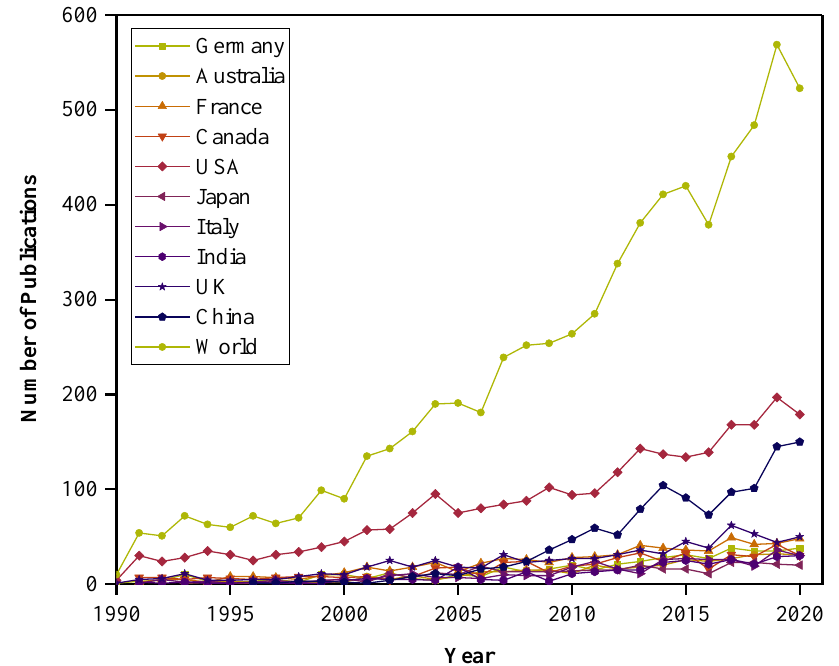
Figure 1. Trends in the number of articles from around the world and major countries.